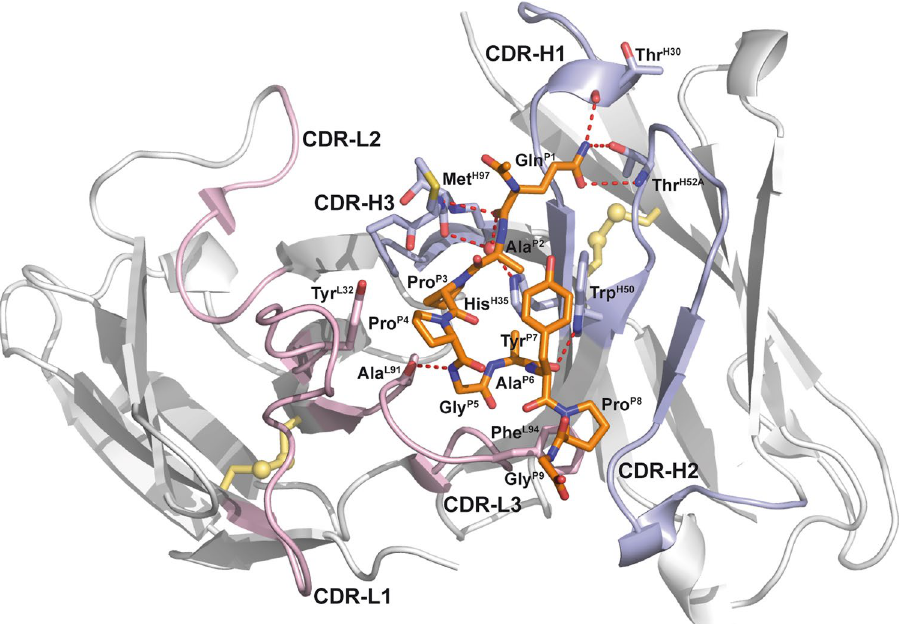
Figure 2. Crystal structure of the chimeric αhGal3-Fab fragment (Fv portion) in complex with the hGal3 epitope peptide, Ac-Gln-Ala-Pro-Pro-Gly-Ala-Tyr-Pro-Gly. The (N-acetylated) hGal3 peptide (residues P1-P9, orange) is bound in a cleft between both variable domains. The secondary structure elements are representated as cartoons and colored in light gray while disulfide bonds are shown yellow in ball-and-stick representation; the CDRs of the light and heavy chains are colored in light pink and light blue, respectively. The mAb residues that are engaged in aromatic contacts or form hydrogen bonds (red dotted lines) to the hGal3 peptide, together with the two residues that form bridged hydrogen bonds through a bound water molecule (red sphere), are depicted as sticks. Those residues that make direct hydrogen bonds to the epitope peptide are labeled (see Table 2).